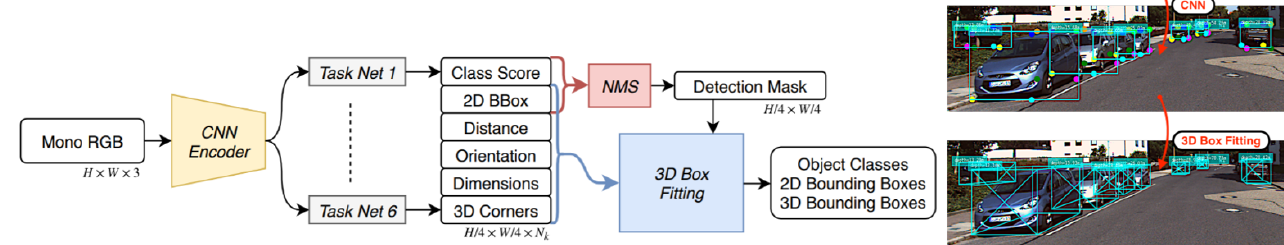
Figure 7. The pipeline of SS3D [57] for 3DOR from a single view.